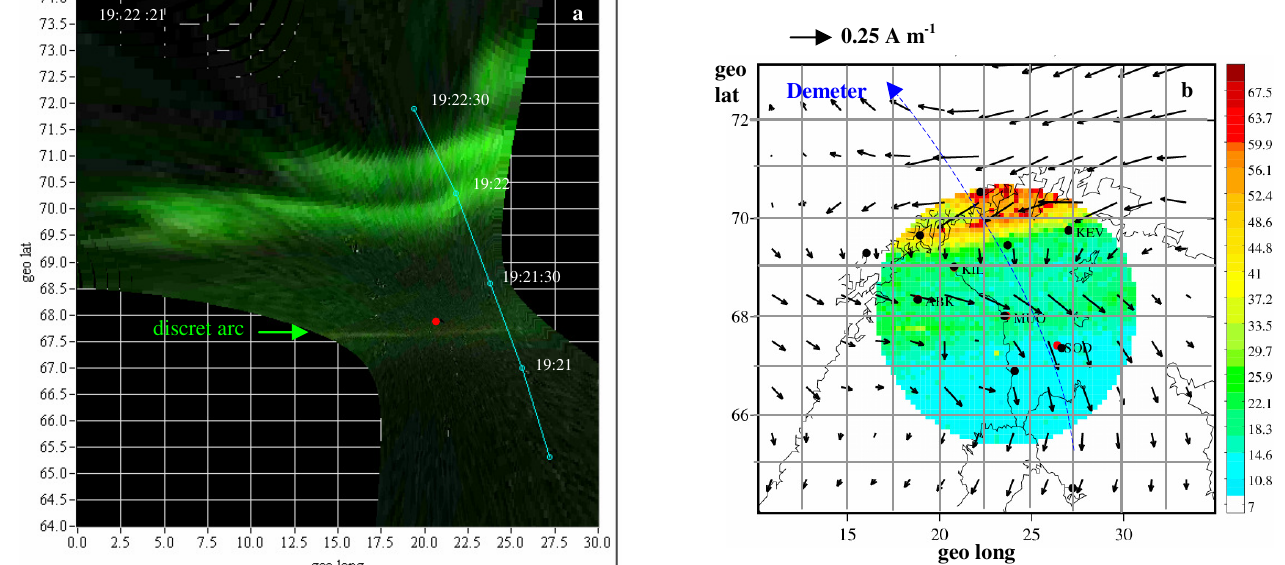
Fig. 2. (a) Wide-band photo-emissions observed by ALFA all-sky camera and (b) 557nm emissions recorded by Muo imager superimposed with equivalent currents (black arrows) deduced from the ground-based magnetic measurements. Filled points display geographical location of ALFA all-sky (a) and Image magnetometers (b). Demeter trajectory projected along the magnetic field lines is shown by blue line. All parameters are presented in geographical coordinates and mapped at the altitude of 110km and correspond to 19:22UT on 19 December 2006.